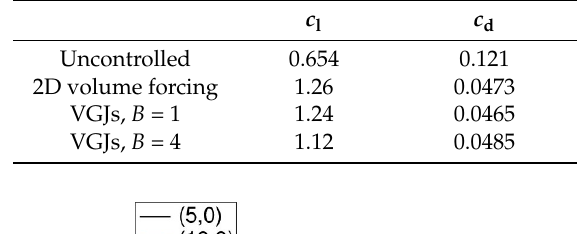
Figure 26. Re = 64,200 and α = 8.64 degrees: ( Top ) Isosurfaces of Q = 1 and isocontours of spanwise vorticity ( − 100 < ω z < 100). ( Bottom ) Suction-surface skin friction ( − 0.01 < c f < 0.01). Uncontrolled ( left ) and 2D volume forcing ( right ). (Reprinted from [31]). Table 2. Lift and drag coefficient. VGJs: vortex generator jets.